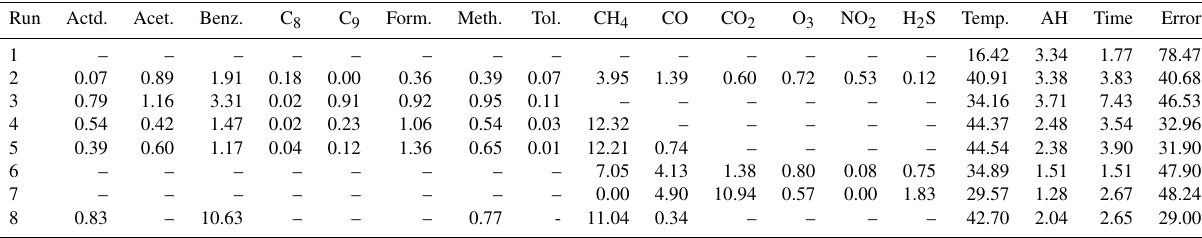
Table 6. Analysis of variance results for the Figaro 2602 sensor signal ( R s /R 0 ). Run Actd.